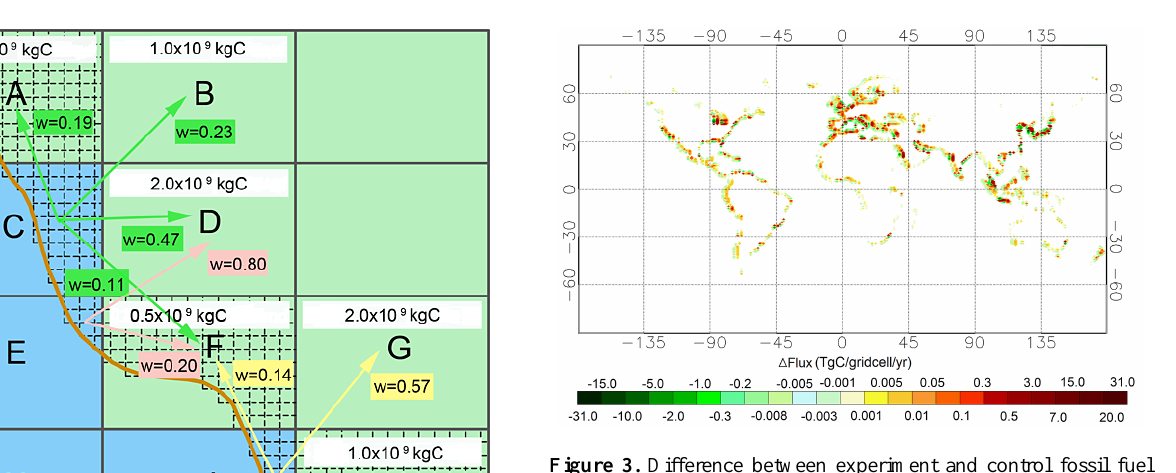
Figure 3. Difference between experiment and control fossil fuel CO 2 emissions. The difference is obtained by subtracting the con- trol from the experiments. The emission values for some grid cells are not evident because the grid cells are saturated (beyond the color scale